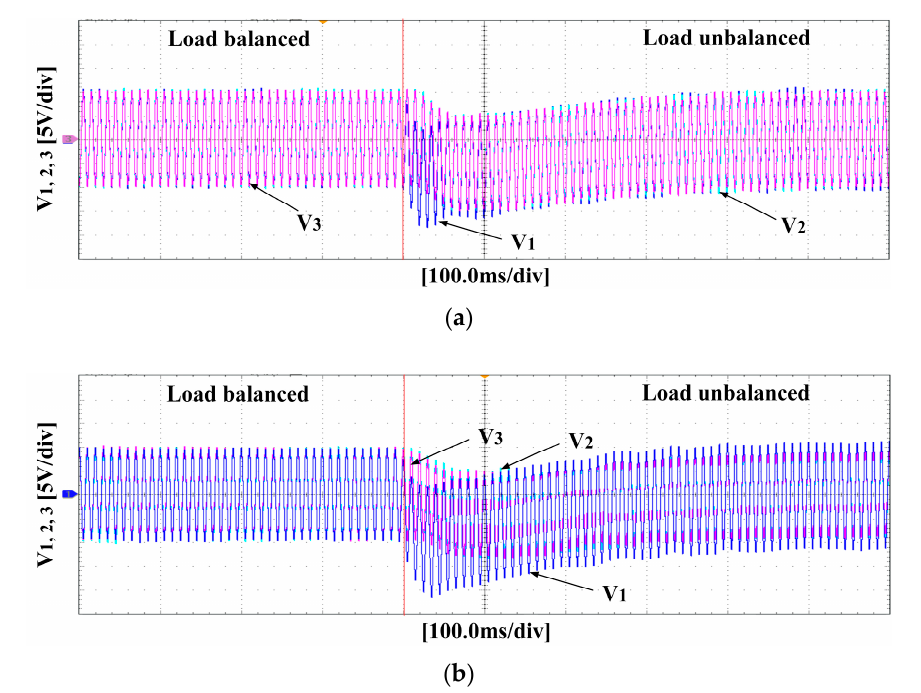
Figure 18. Experimental waveforms of the dc-link voltage of the CHBR modules under load variation by use of ( a ) the proposed control strategy and ( b ) the conventional control strategy.